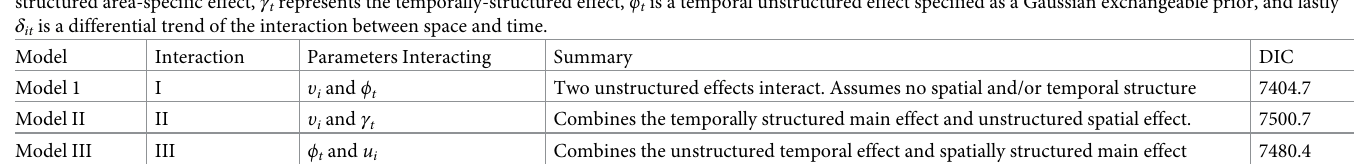
it is a differential trend of the interaction between space and